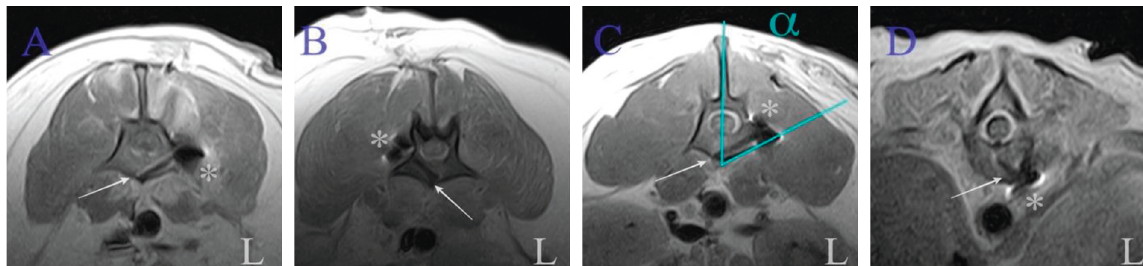
Figure 7: Postoperative transverse T1-weighted MR images of lumbar (a, b, and c) and thoracic (d) spine of four different dogs showing implantation of monocortical screws (arrow). Minor susceptibility artifacts are associated with orthopedic implants ( ∗ ). Angle ( α ) of implantation in lumbar vertebra is close to expected [26, 29].